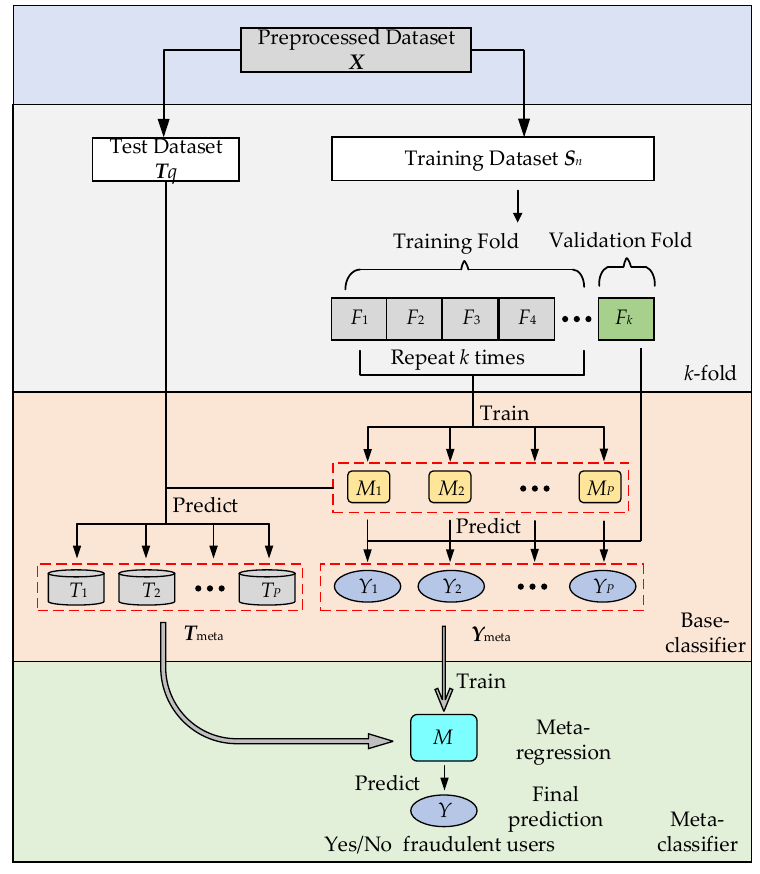
Figure 3. Structure of stacking integrated model.